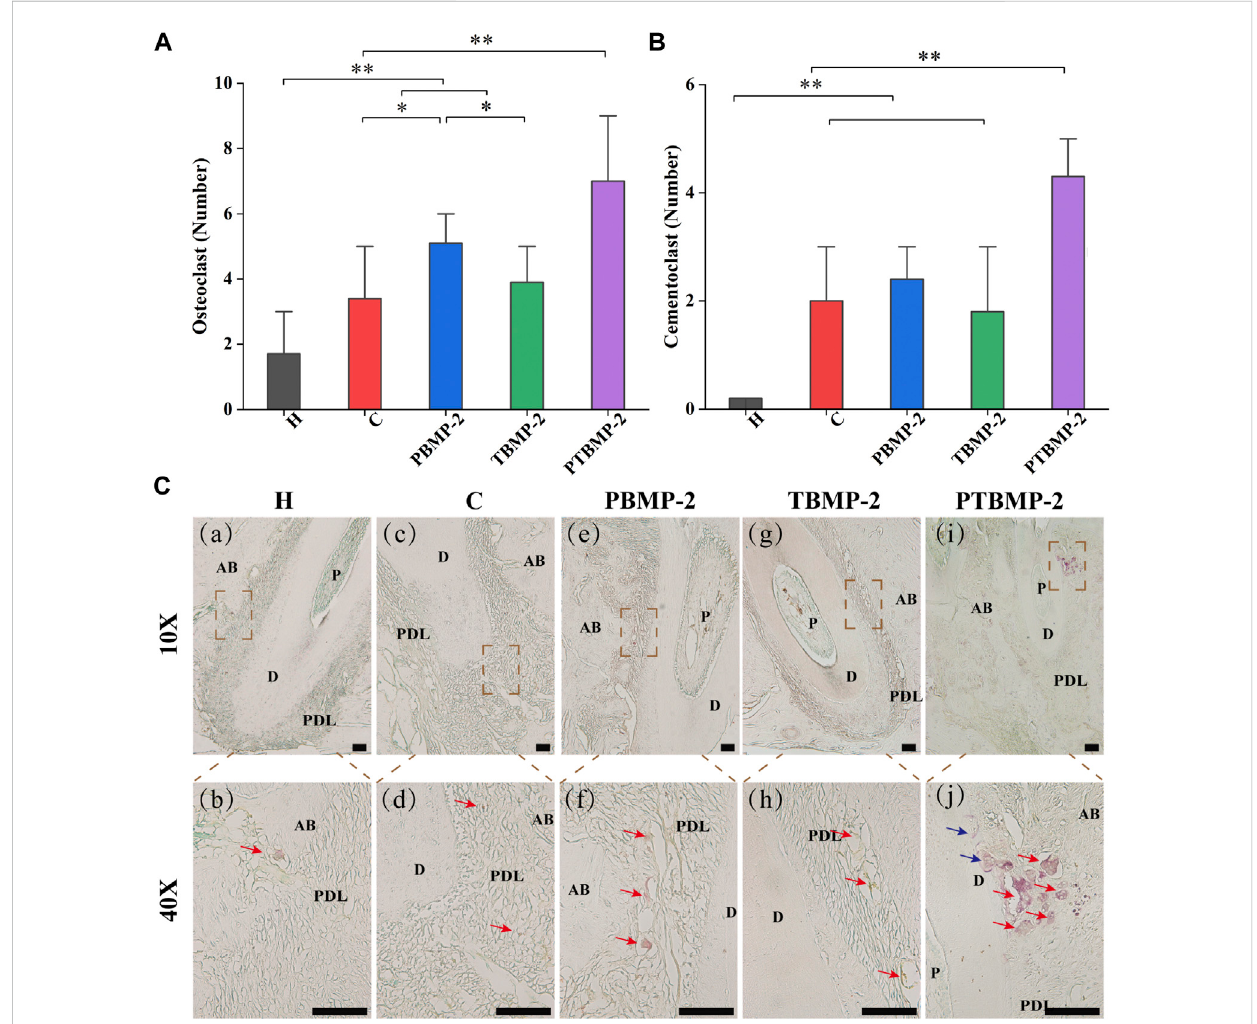
FIGURE 8 Histological measurement of osteoclasts (A) and cementoclasts (B) on TRAP-stained sections. Data are presented as mean and standard deviation. *Signi fi cant( p < 0.05)differencebetweengroups,**Signi fi cant( p < 0.01)differencebetweengroups.LightmicrographsofsagittalTRAP-stainedsections of the mesial root of left maxillary fi rst molar (M1) in ×10 magni fi cation and ×40 magni fi cation (C) . → , osteoclast appeared as trap-stained red-positive multinucleated giant cells found in resorption traps or on the surface of the alveolar bone. → , cementoclasts appeared as positive multinucleated giant cells on the root surface deep within the resorption traps of dentin. Scale bar = 100 μ m. AB, alveolar bone; D, dentin; PDL, periodontal